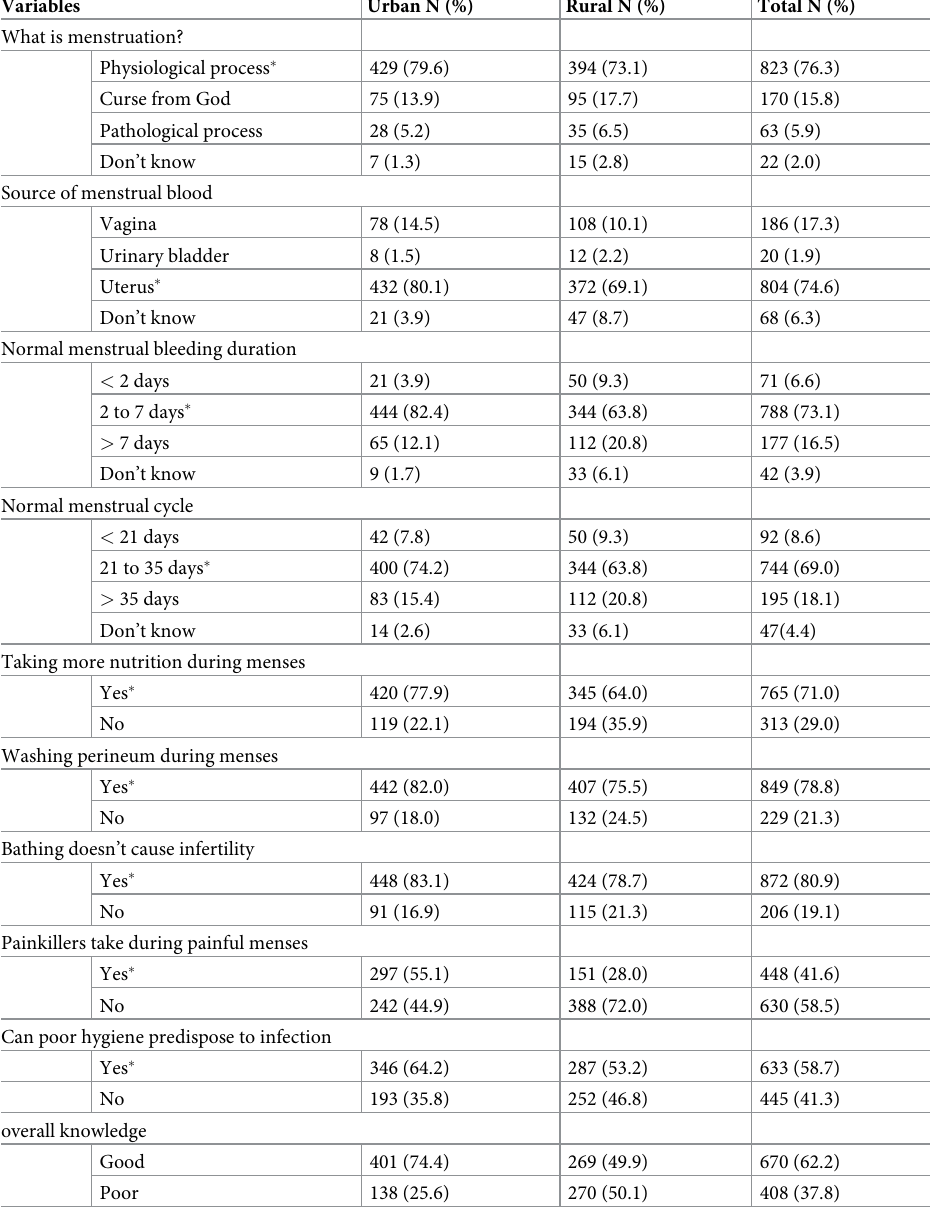
Table 2. Knowledge about menstrual hygiene among urban and rural schoolgirls in North Wollo Zone, Northeast Ethiopia, 2020 (N = 1078; 539 urban and 539 rural).